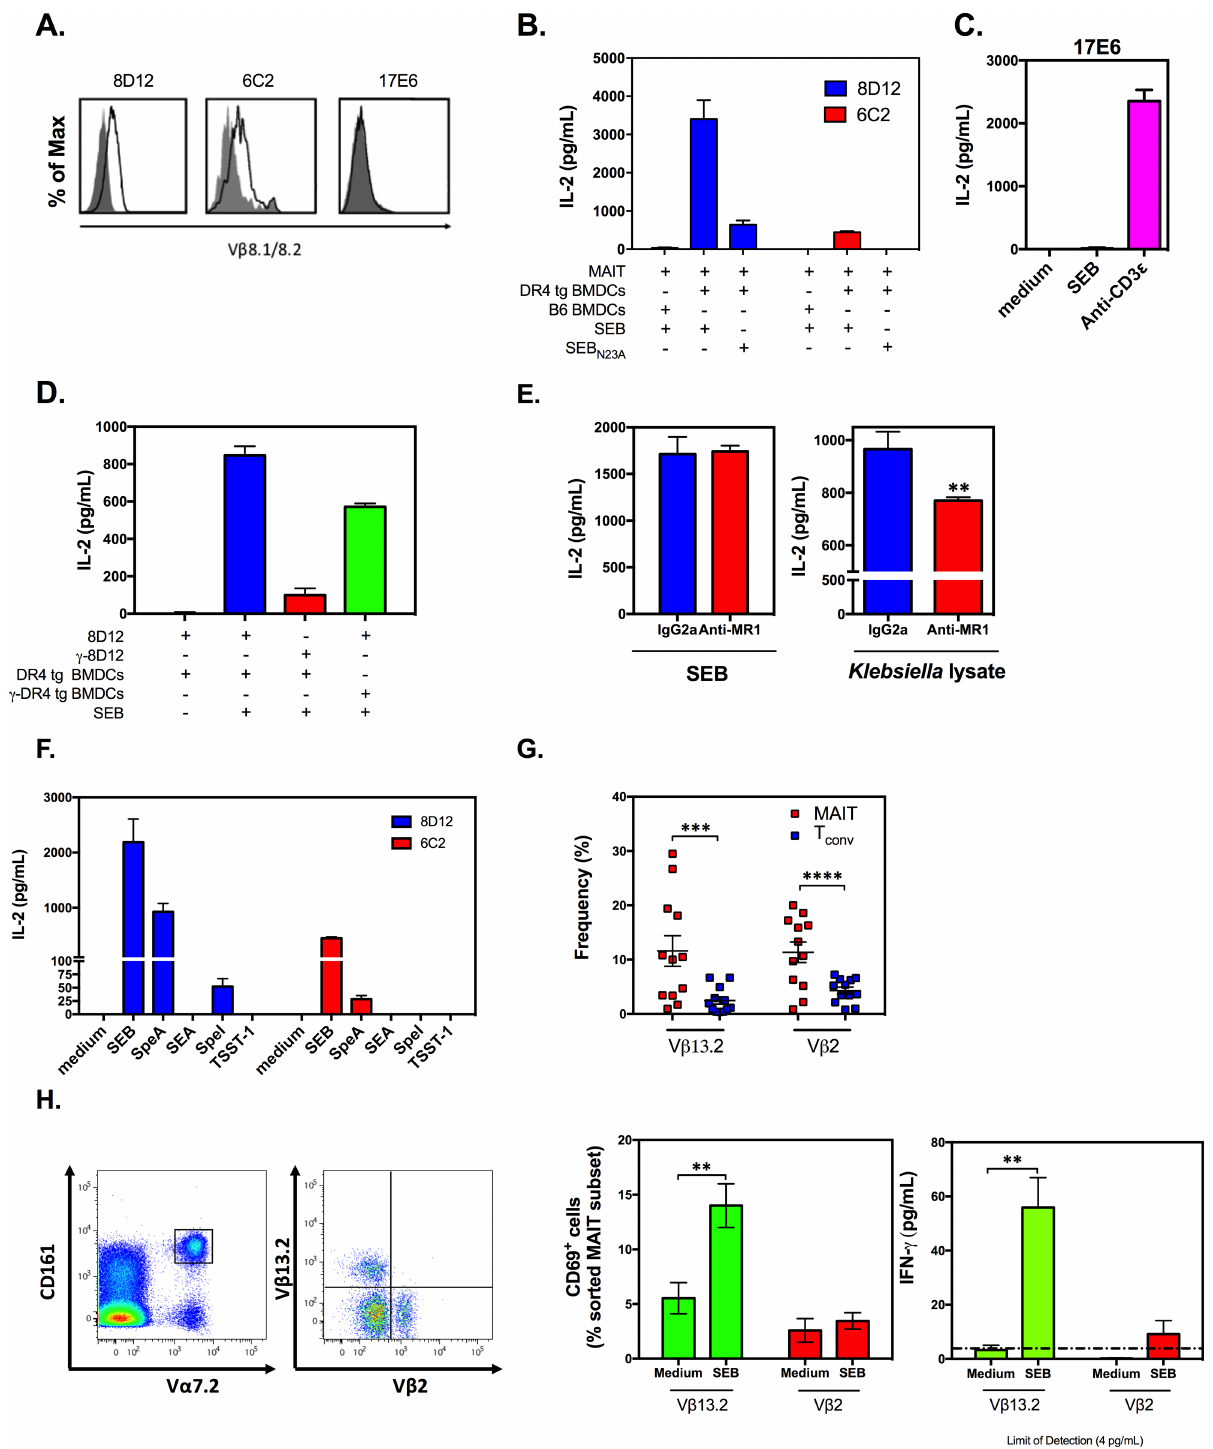
Fig 5. Mouse and human mucosa-associatedinvariant T (MAIT) cells can be activated by staphylococcal and streptococcal superantigens (SAgs) in a T cell receptor (TCR) V β -dependent manner. Mouse MAIT hybridoma lines 8D12, 6C2, and 17E6 were evaluatedby flow cytometry for TCR V β 8.1/2 expression( A ). Indicatedhybridoma(s) were exposedto 100 ng/mL of staphylococcal enterotoxinB (SEB) ( B-F ), SEB N23A ( B ), or several SAgs other than SEB ( F ) or stimulatedwith 0.5 μ g/mL of an anti-CD3 ε mAb ( C ) or with Klebsiella lysate ( E ) in the presenceof DR4-transgenic (DR4 tg) bone marrow-derived dendriticcells (BMDCs) ( B-F ), wild-typeC57BL/6